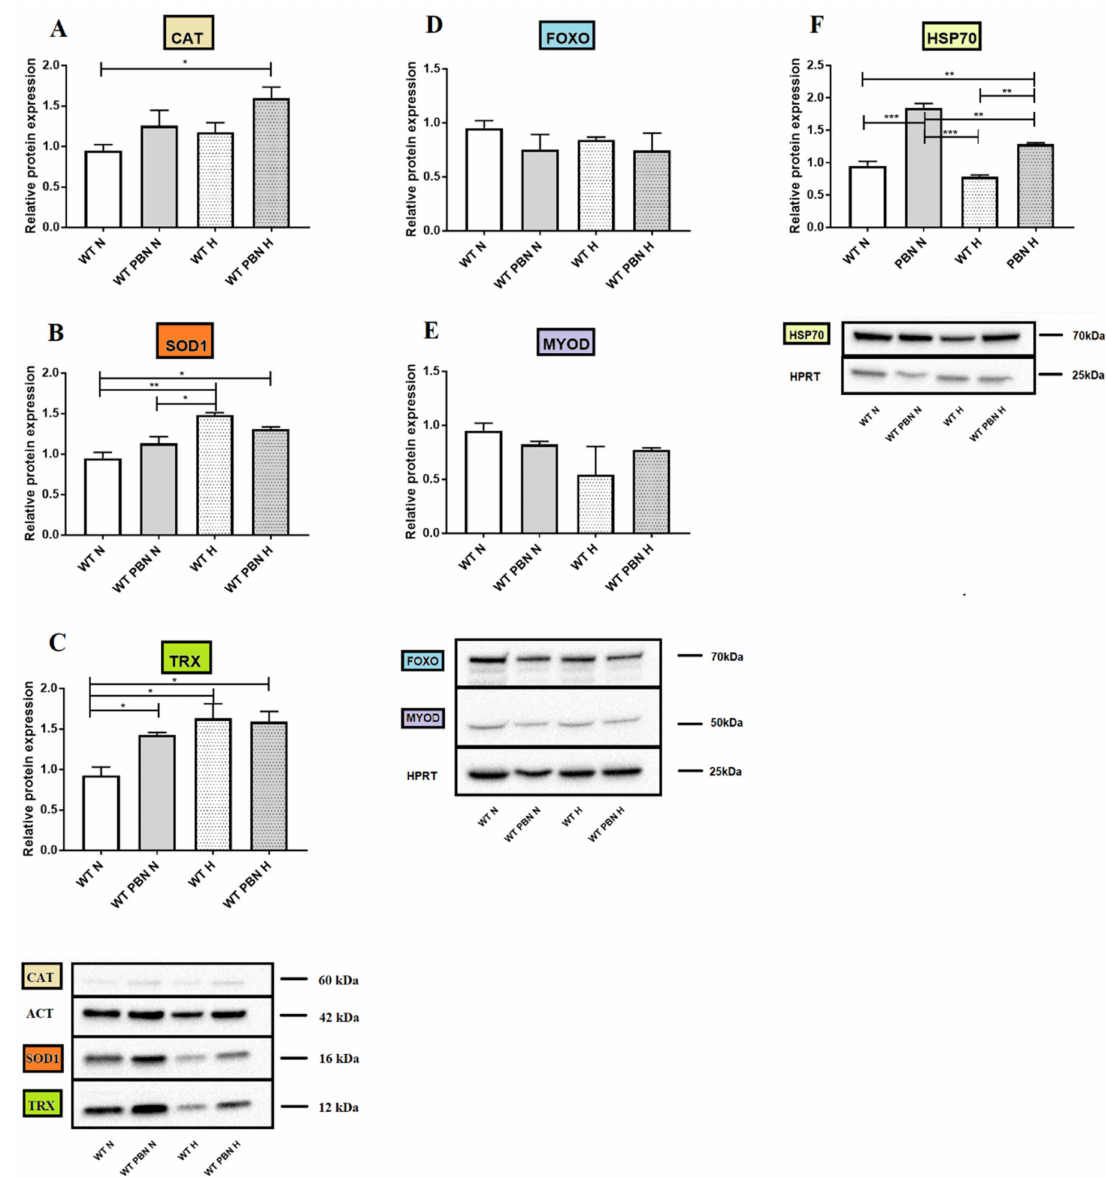
Figure 8. Amount of protein superoxide dismutase 1 (SOD1) ( A , catalase (CAT) ( B ), thyredoxin (TRX) ( C ), forkhead box O3 ( D ), myoblast determination protein 1 (MYOD) ( E ), heat shock protein 70 (HSP70) ( F ), and housekeeping proteins: hypoxanthine-guanine phosphoribosyltransferase (HPRT) and actinin (ACT) in non-treated (WT) and PBN- conditioned (PBN) SkMDS/PCs populations cultured under standard (N) and hypoxic (H) in vitro conditions. Abbre- viations: SkMDS/PCs = skeletal muscle derived stem/progenitor cells; WT = wild-type non-treated SkMDS/PCs; PBN = SkMDS/PCs cultured in medium conditioned with tert-butyl-alpha-phenyl nitrone. * significant at p value <0.05, ** significant at p value <0.01, *** significant at p value